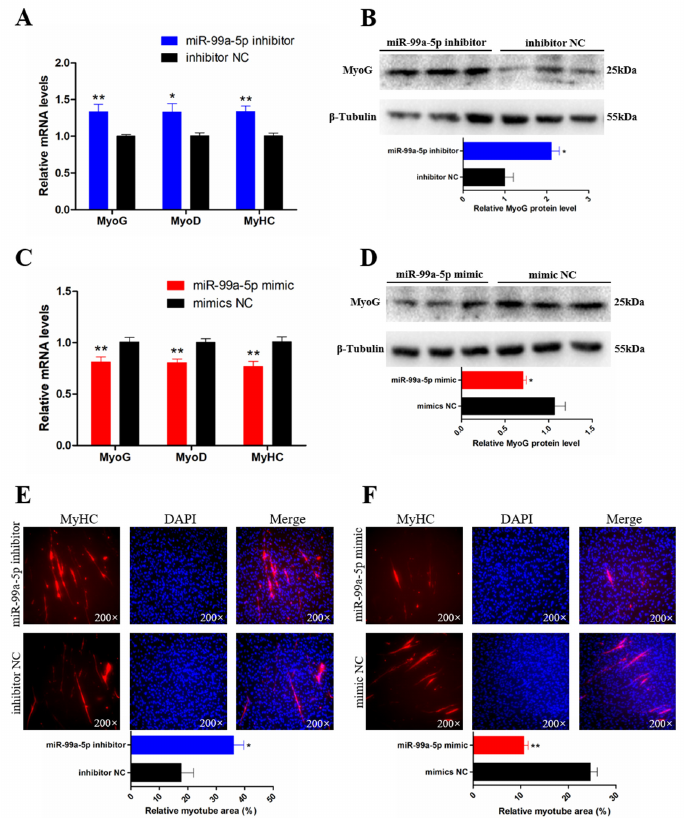
Figure 3. miR-99a-5p inhibits the di ff erentiation of chicken SMSCs. ( A , C ) The mRNA levels of muscle cell di ff erentiation marker genes were detected by qRT-PCR in SMSCs after overexpression and inhibition of miR-99a-5p. ( B , D ) Western blotting results of myogenin (MyoG) in SMSCs after transfection with miR-99a-5p mimic and inhibitor (upper panels). The relative protein level of MyoG in SMSCs after overexpression and inhibition of miR-99a-5p. ( E , F ) Anti-Myosin heavy chain (MyHC) immunofluorescence staining after the transfection of miR-99a-5p mimic and inhibitor in SMSCs (upper panels). Relative myotube area of chicken SMSCs following miR-99a-5p overexpression and inhibition (lower panels). Results are shown as mean ± SEM and the data are representative of at least three independent assays. Student’s t -test was used to compare expression levels among di ff erent groups. * p < 0.05; ** p <